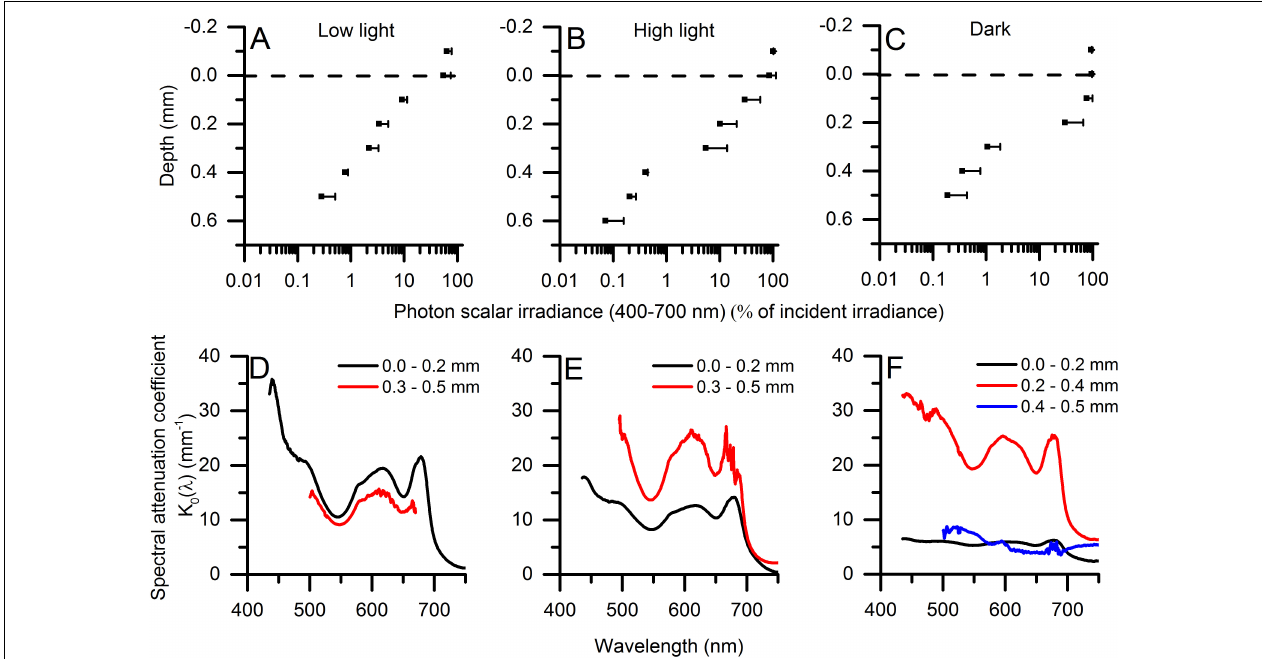
FIGURE 2 | (A–C) Vertical microprofiles of photon scalar irradiance (PAR; 420–700 nm) (in µ mol photons m − 2 s − 1 ). The dashed line indicates the biofilm surface. [means ± 1 SD (only + SD shown for clarity); n = 3]. PAR attenuation coefficients, K 0 , were estimated in the upper- and lower part of the biofilm (0.0–0.2 mm; 0.3–0.5 mm) from the slope of linear regressions on natural logarithm transformed data ( R 2 > 0.95 for all plots). (D–F) Shows spectral attenuation coefficients, K 0 ( λ ) (in mm − 1 ) in different zones of the biofilm ( n = 3). The measurements were done in low light-acclimated (left panels), high light-acclimated (middle panels), and dark-acclimated biofilms (right panels). At depth in the mats, very low light levels led to decreasing signal to noise ratios and increasing contributions by straylight in the spectrometer at shorter wavelengths and spectra were therefore truncated.